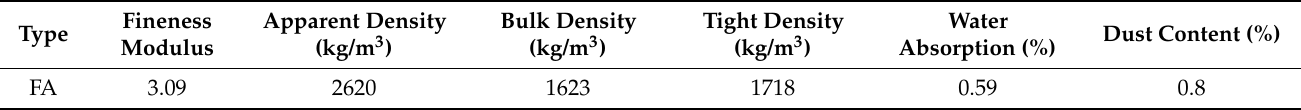
Table 1. Performance indexes of river sand.